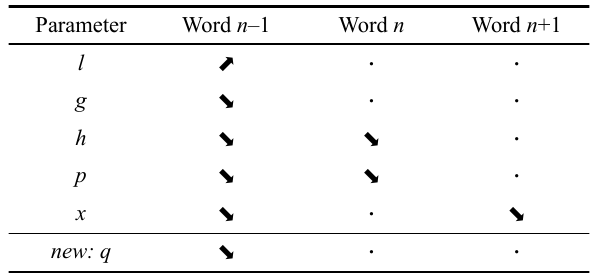
Table 1 Main Effects of Lexical Parameters on Single Fixation Durations